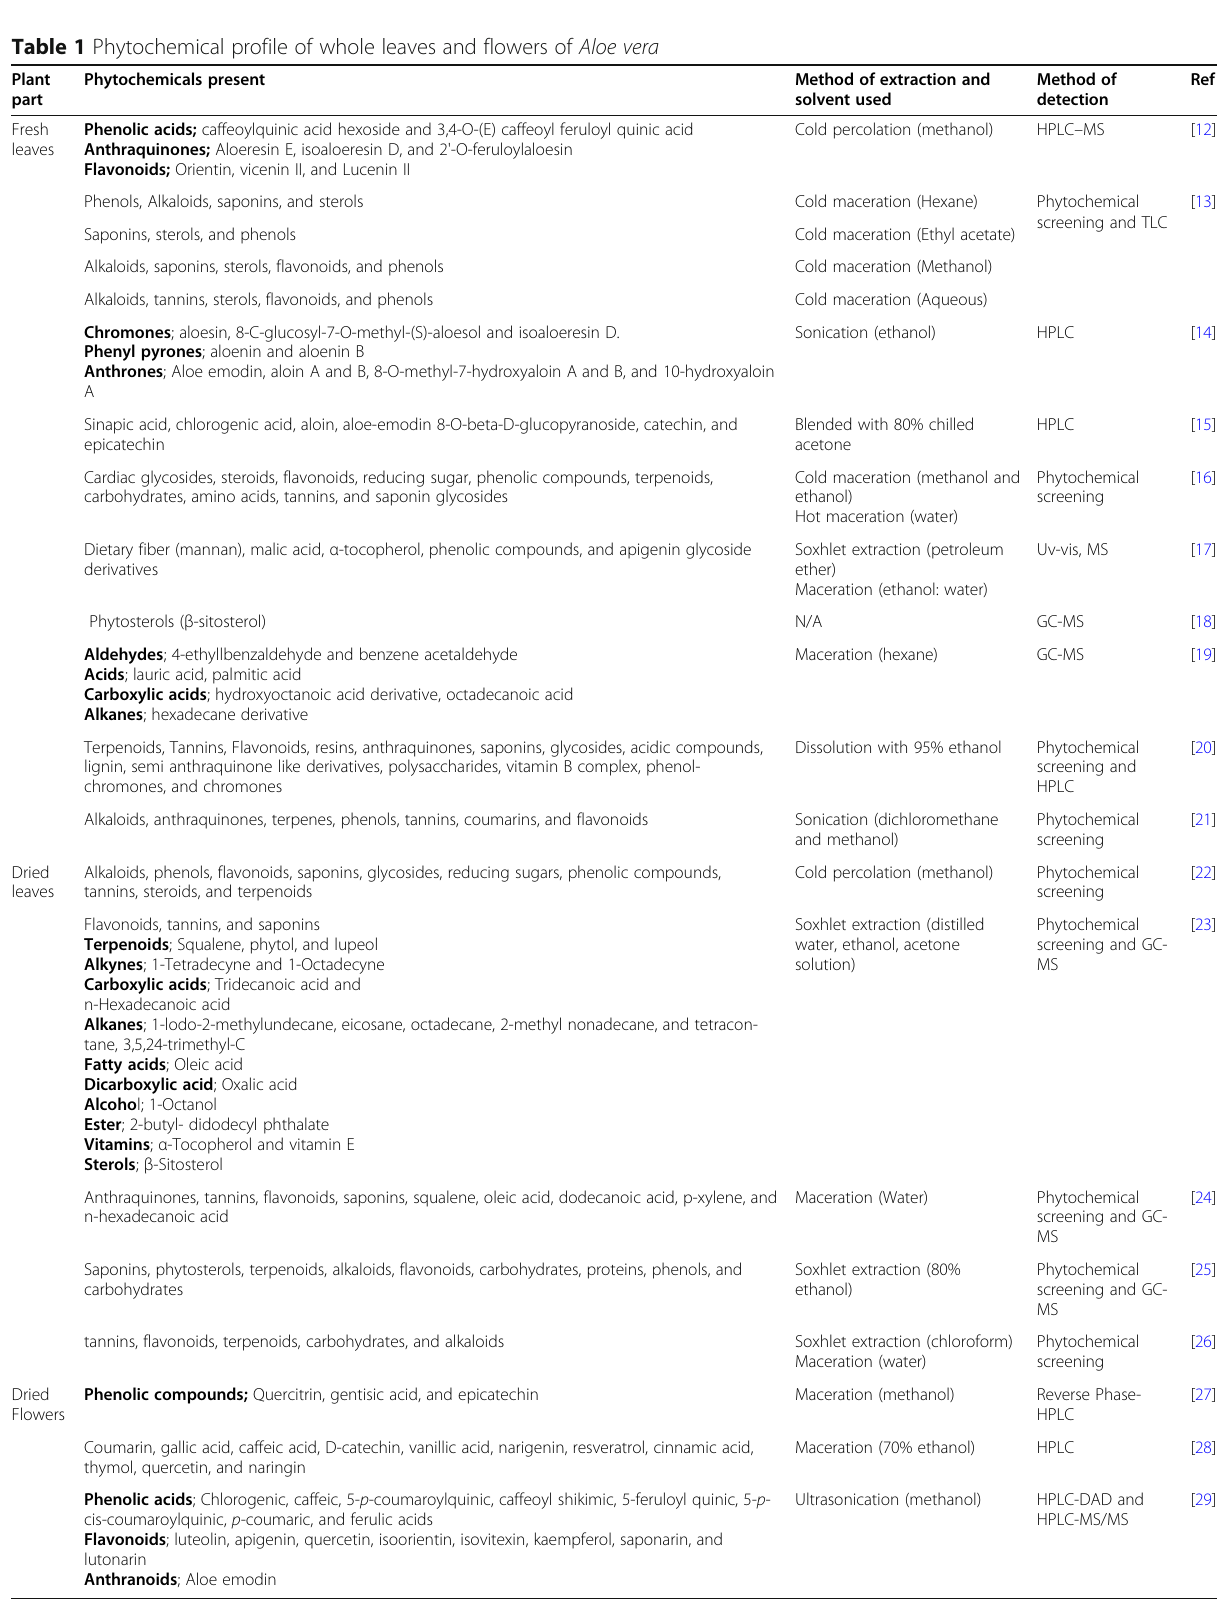
Table 1 Phytochemical profile of whole leaves and flowers of Aloe